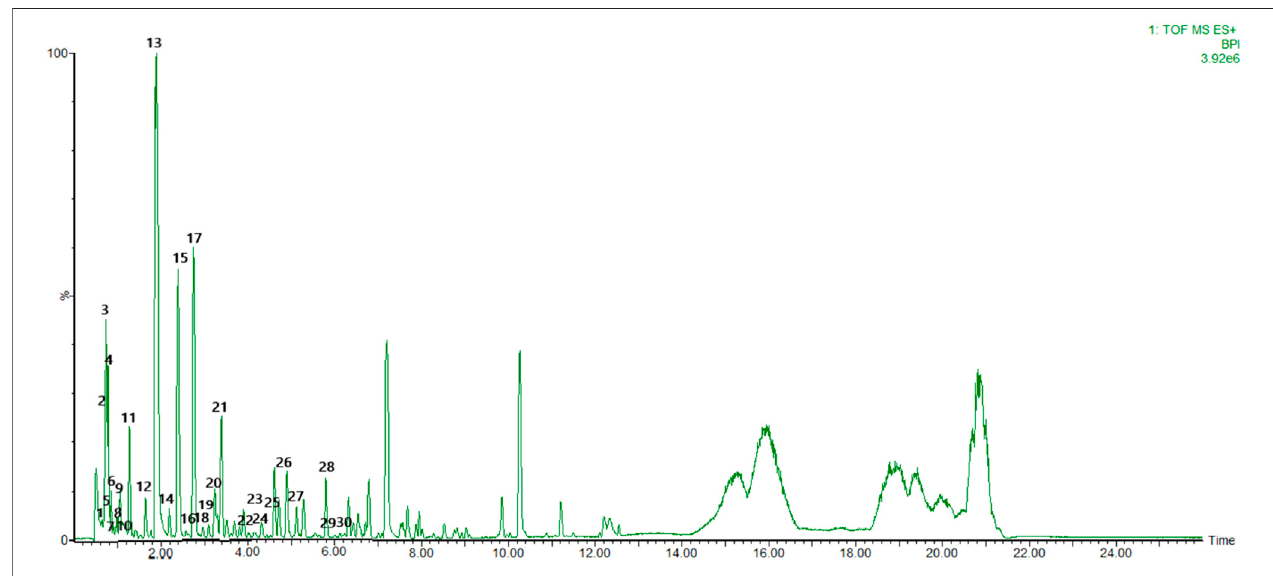
FIGURE 1 | Base peak chromatogram with positive mode of the aqueous extract of